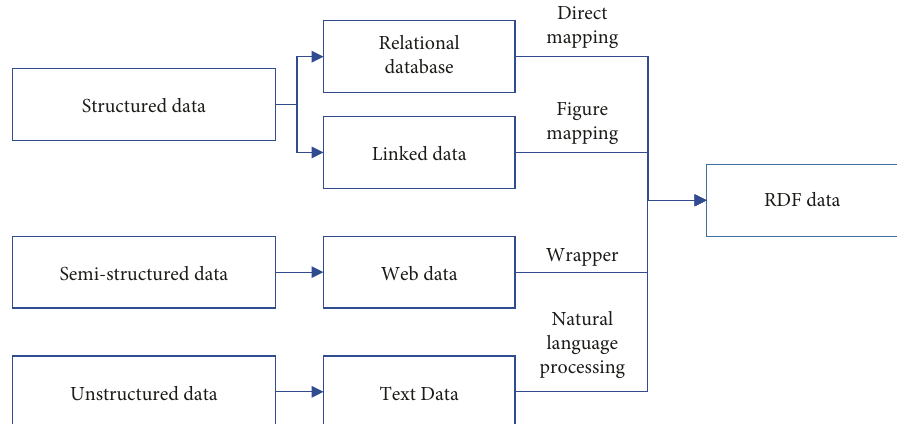
Figure 5: Schematic diagram of knowledge extraction method for multisource heterogeneous